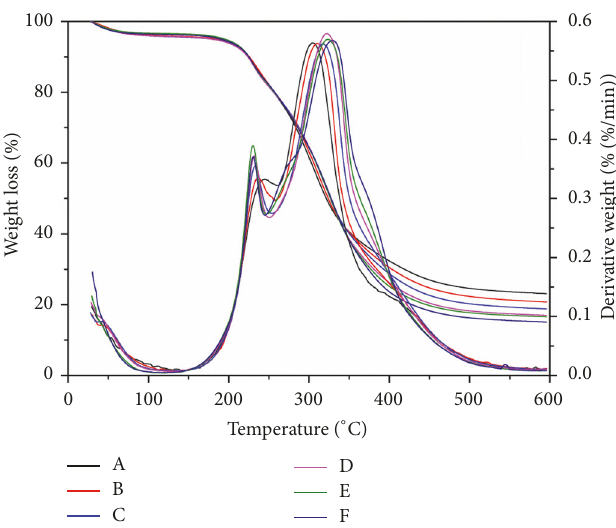
Figure 5: The TGA and dTG curves of cured unmodified and EGDE-modified SF adhesives.